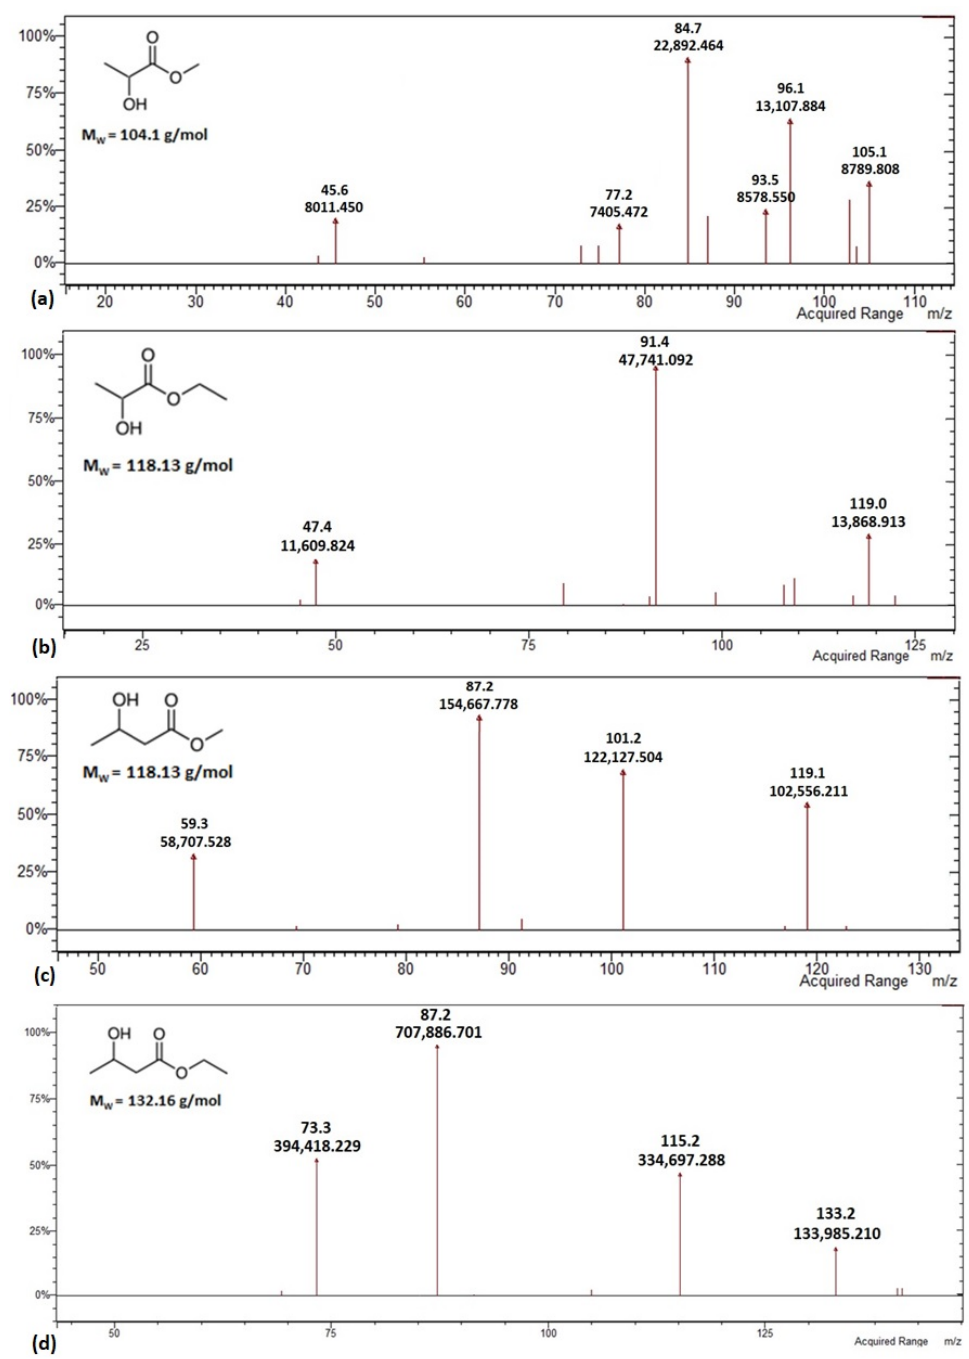
Figure 5. MS spectra of the synthesized alkyl monoesters based on PLA and PHB. ( a ) Methyl lactate (MeLa); ( b ) Ethyl lactate (EtLa); ( c ) Methyl 3-hydroxybutyrate (M3HB); ( d ) Ethyl 3-hydroxybutyrate (E3HB).